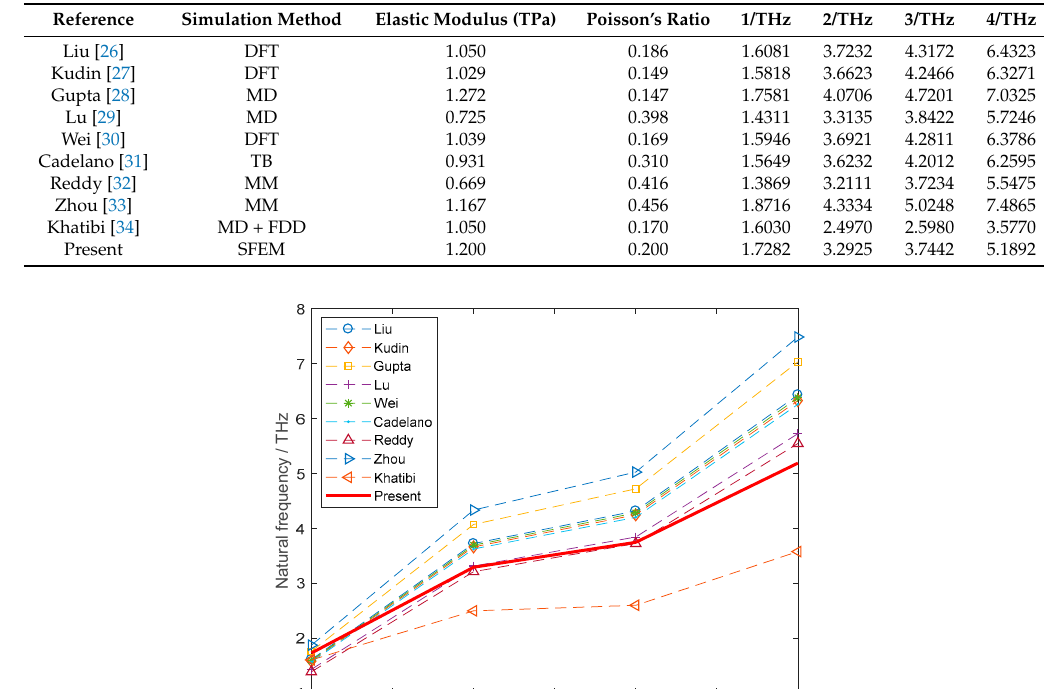
Table 1. Comparing the natural frequencies obtained from present model with that in references [26–34].